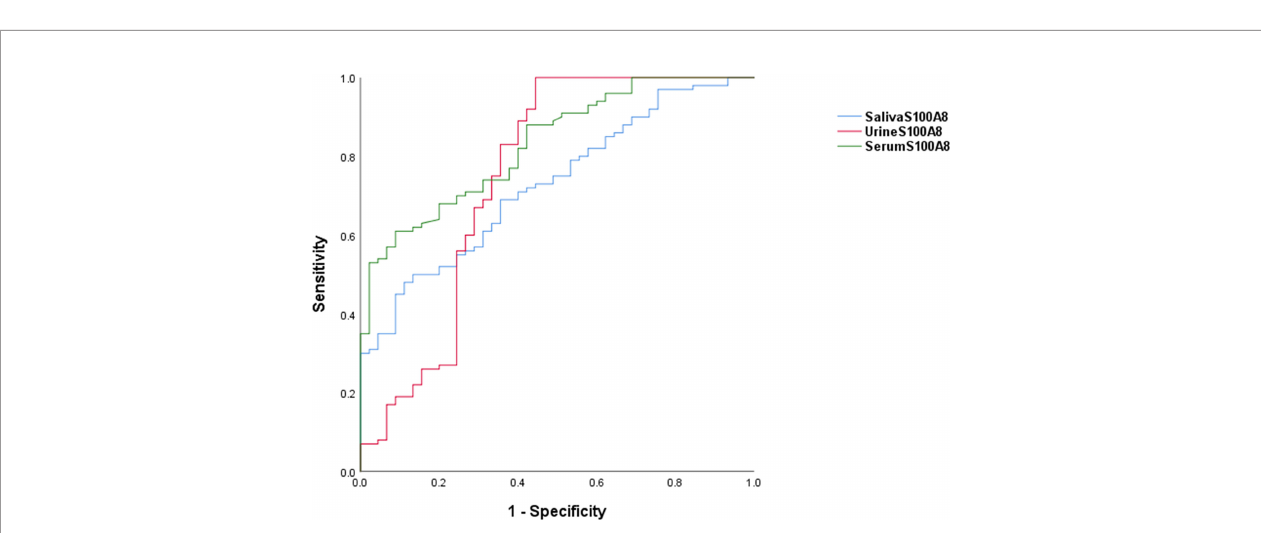
FIGURE 2 | Receiver operating characteristic curves associated with the diagnostic utility of S100A8 in serum, urine, and saliva. For SLE diagnosis, the AUC was 0.831 for the serum S100A8 (95% CI, 0.765 – 0.897), 0.751 for the urine S100A8 (95% CI, 0.648 – 0.854), and 0.729 for the salivary S100A8 (95% CI, 0.646 – 0.812). AUC, area under the receiver operating characteristic curve; SLE, systemic lupus